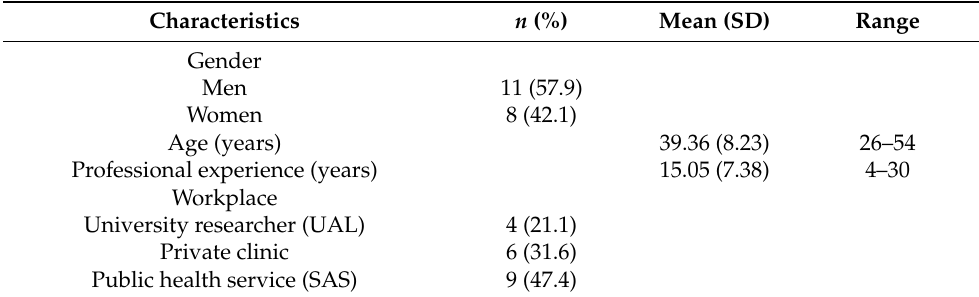
Table 1. Selected characteristics of physiotherapists ( n =